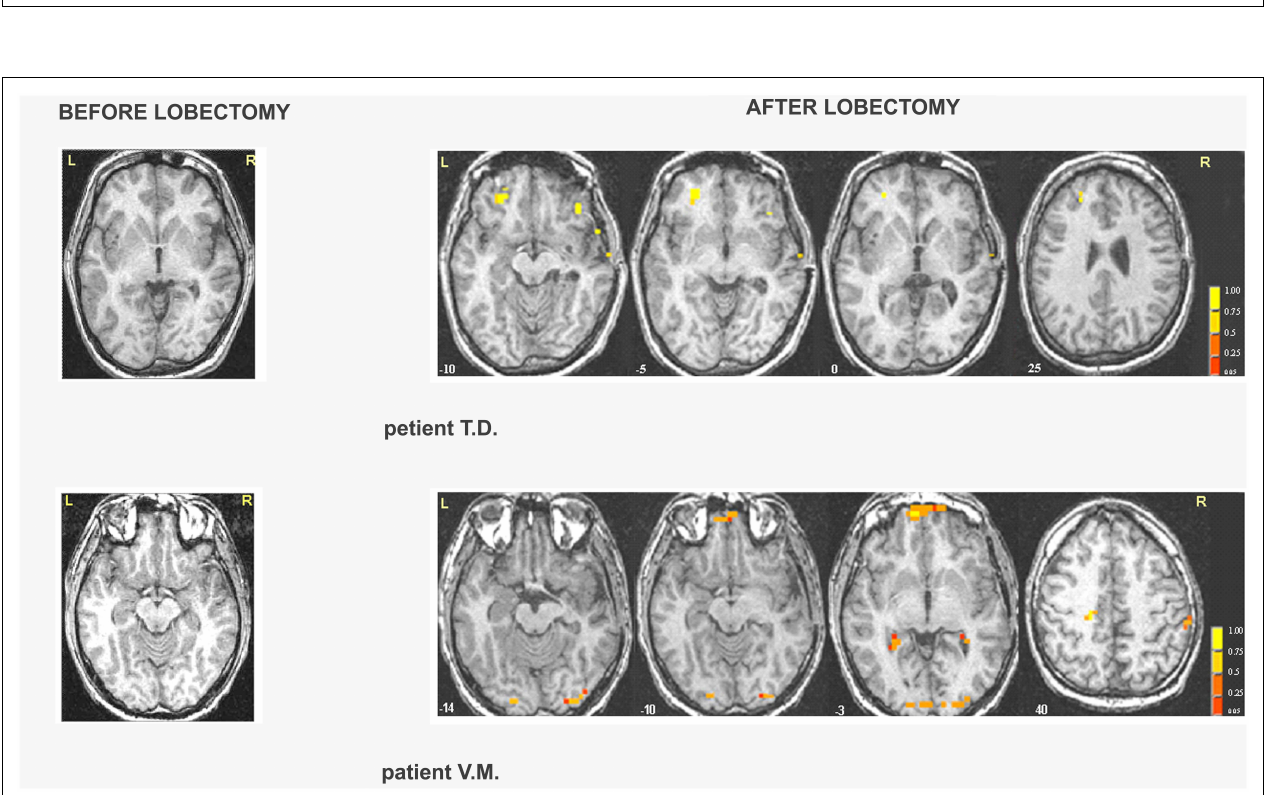
FIGURE 2 |Areas of significant activation in response to faces in right MTLE patients before and after lobectomy .The numbers at the bottom of each sagittal slice represent z -axis levels according toTalairach coordinates.The statistical threshold is set at p < 0.001 (uncorrected).The activated clusters are superimposed on each single patient’s structural image.